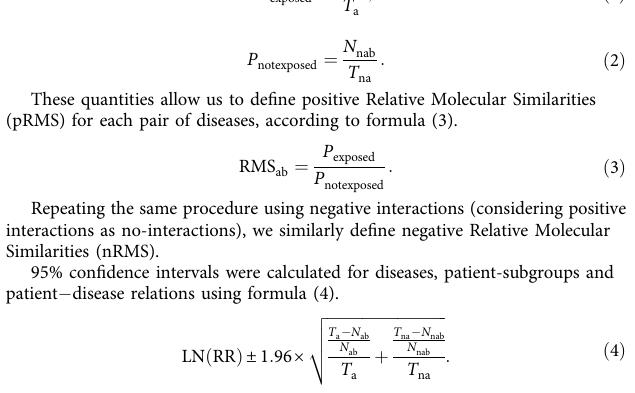
ffiffiffiffiffiffiffiffiffiffiffiffiffiffiffiffiffiffiffiffiffiffiffiffiffiffiffiffiffiffiffi v u u T a (cid:2) N ab T na (cid:2) N nab t N ab N nab : ð 4 Þ þ T a